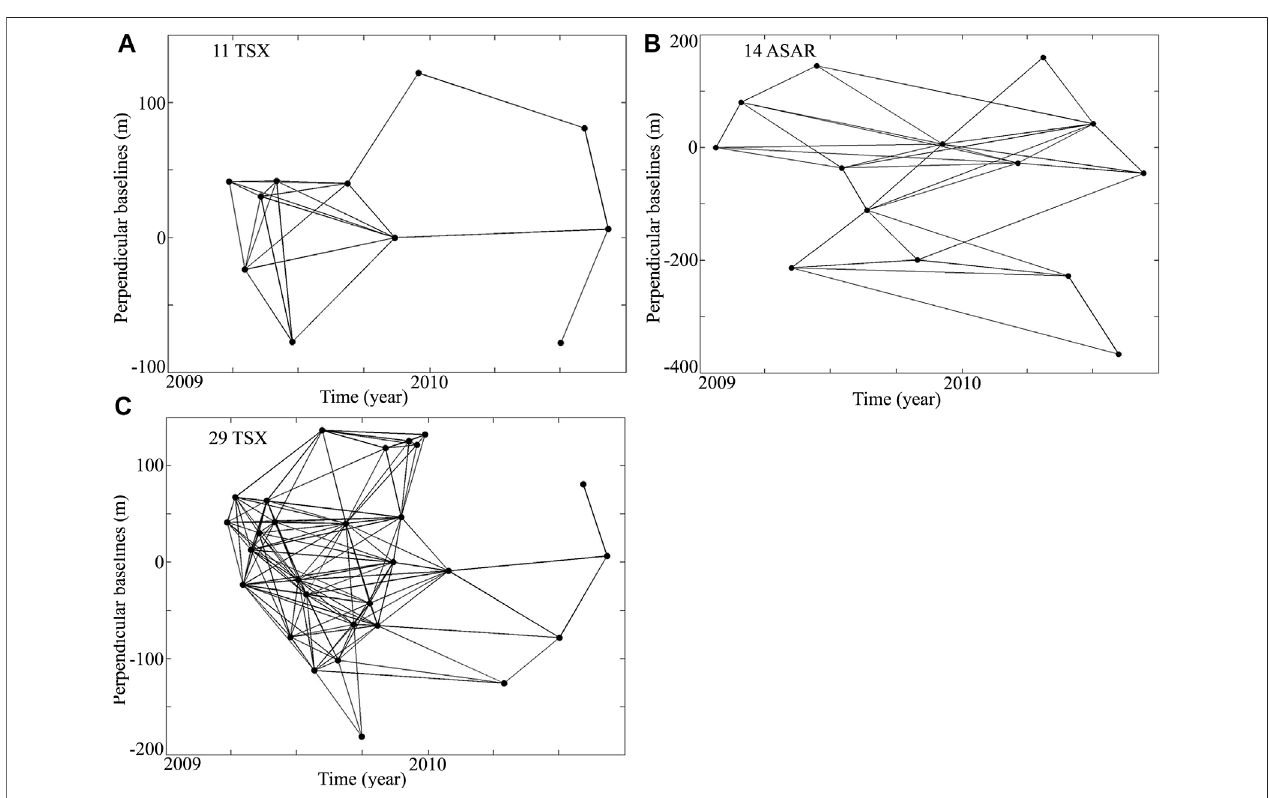
FIGURE 5 | Distribution of temporal and perpendicular baselines of interferograms generated from (A) 11 TSX acquisitions, (B) 14 ASAR acquisitions, and (C) 29 TSX acquisitions. The black dots denote the SAR acquisitions; black lines denote the interferograms.